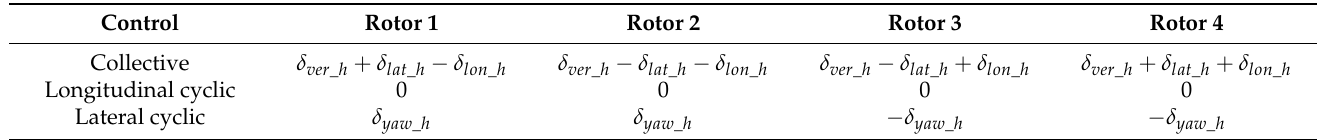
Table 4. Relationship between control value for each rotor and control input. Rotor